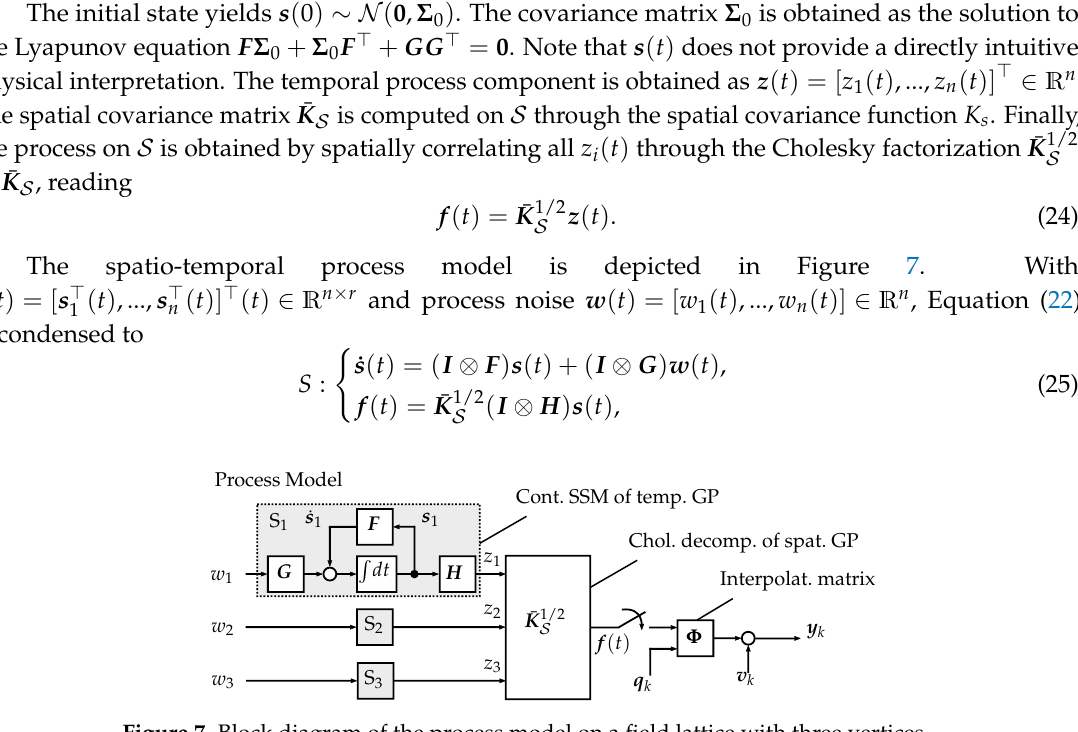
Figure 7. Block diagram of the process model on a field lattice with three